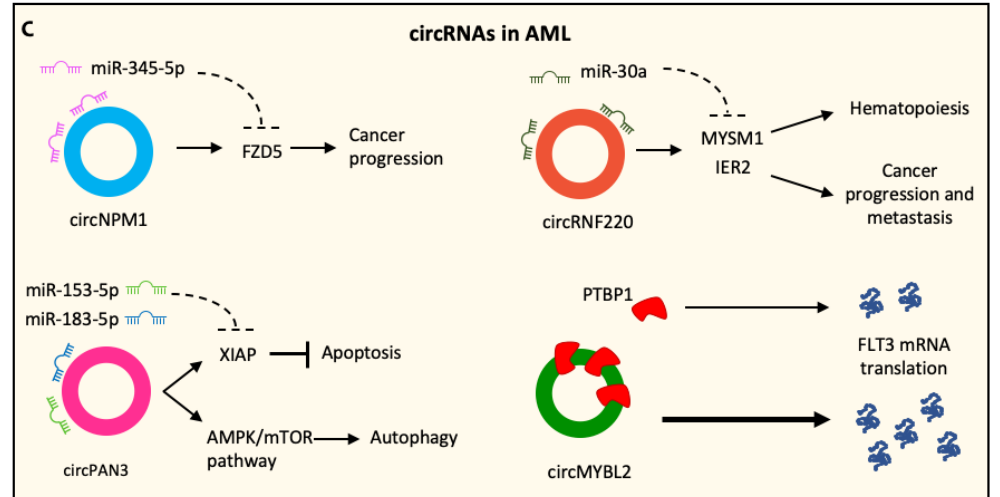
Figure 1. A. circRNAs biogenesis. circRNAs are generated by unconventional splicing, named back-splicing, in which the 3’ end of an exon binds the 5’ end of an upstream exon, forming a co- valently closed molecule. circRNAs can be divided into three main classes: single or multi-exonic circRNAs (on the left), which can translocate in the cytoplasm; exonic-intronic circRNAs (in the middle) and intronic-circRNAs (on the right), which are retained in the nucleus. B. circRNAs func- tions. CircRNAs can regulate transcription, interacting with Polymerase-II (Pol II) in the nucleus. In the cytoplasm, they can act as microRNA sponges or RBP sponges, and they can also be trans- lated thanks to the presence of an IRES or m6A modification. C. circRNAs in AML. Representation of some circRNAs involved in AML progression: circNPM1 acts as miR-345–5p sponge, increasing FZD5 expression, a well-known oncogene; circPAN3, sponging miR-153-5p and miR-183-5p, leads to increased autophagy and inhibits apoptosis; circRNF220 induces MYSM1 and IER2, affecting hematopoiesis and promoting cancer progression and metastasis; circMYBL2 favors mRNA FLT3 translation by binding